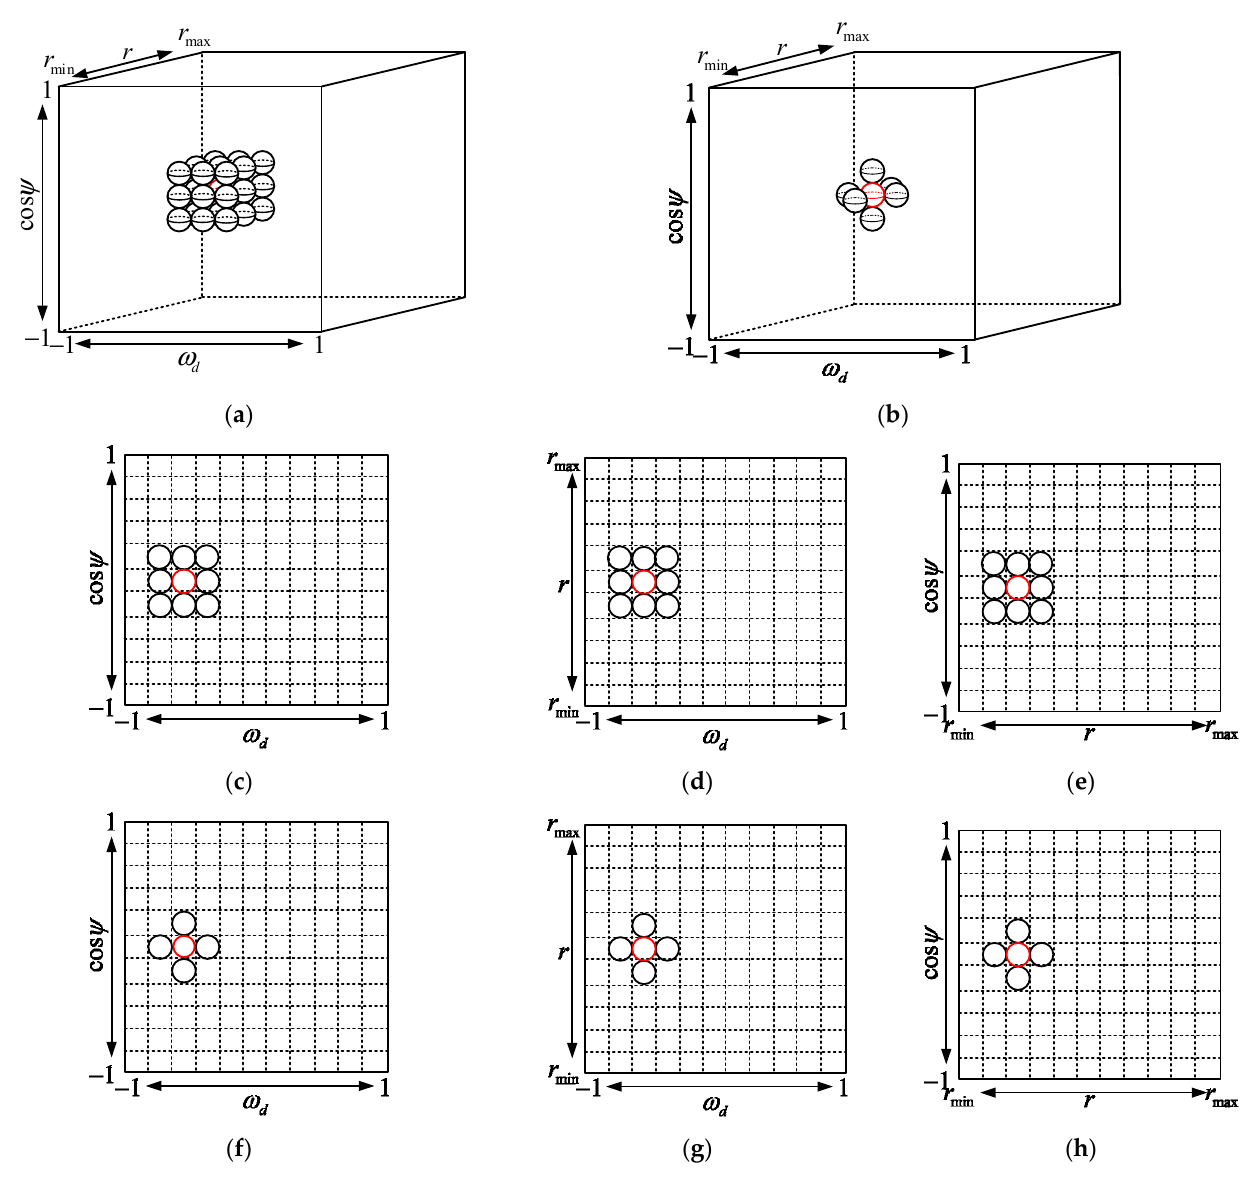
Figure 4. Auxiliary channel selection structure for different dimensionality reduction method: ( a ) Method 3.a; ( b ) Method 3.b; ( c – e ) Downscaling structure in different domain of method 3.a; ( f – h ) Downscaling structure in different domain of method 3.b.